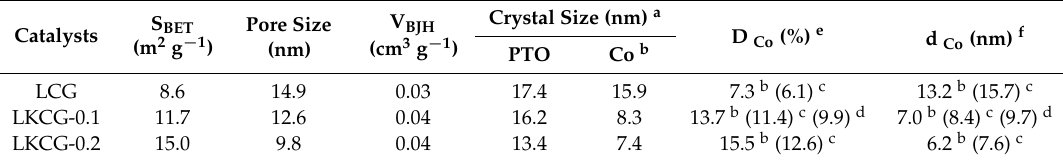
Figure 3. ( a ) The N 2 physical adsorption curves and ( b ) Barrett–Joyner–Halenda (BJH) pore size distribution of catalysts. Table 2. The physical properties of all the investigated catalysts.